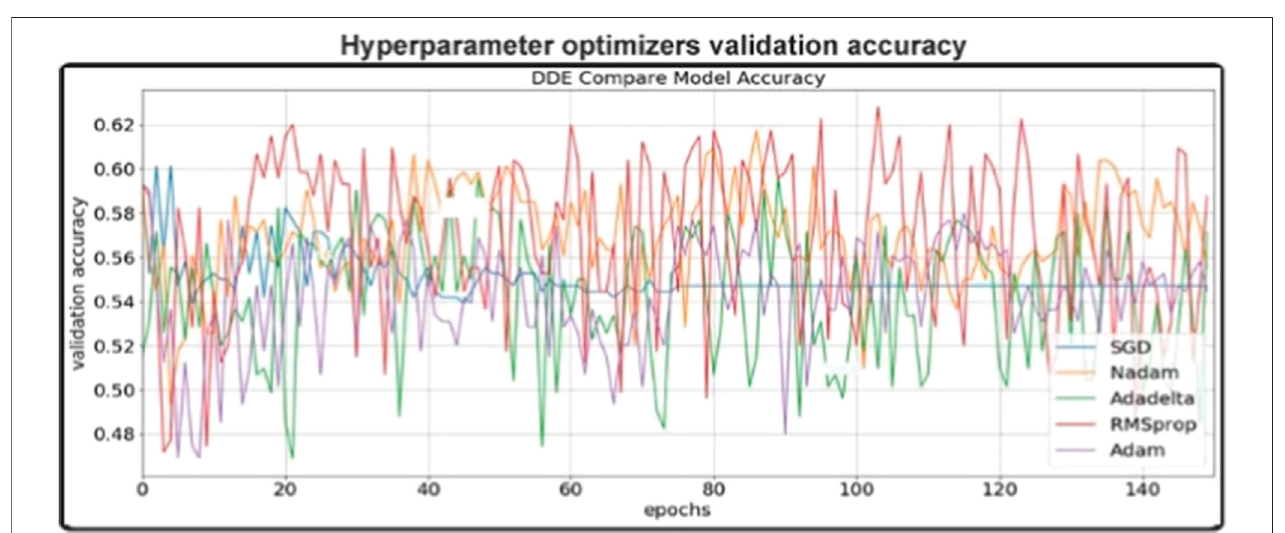
FIGURE 5 | validation accuracy of different optimizers in this study (The epoch ranges from 0 to